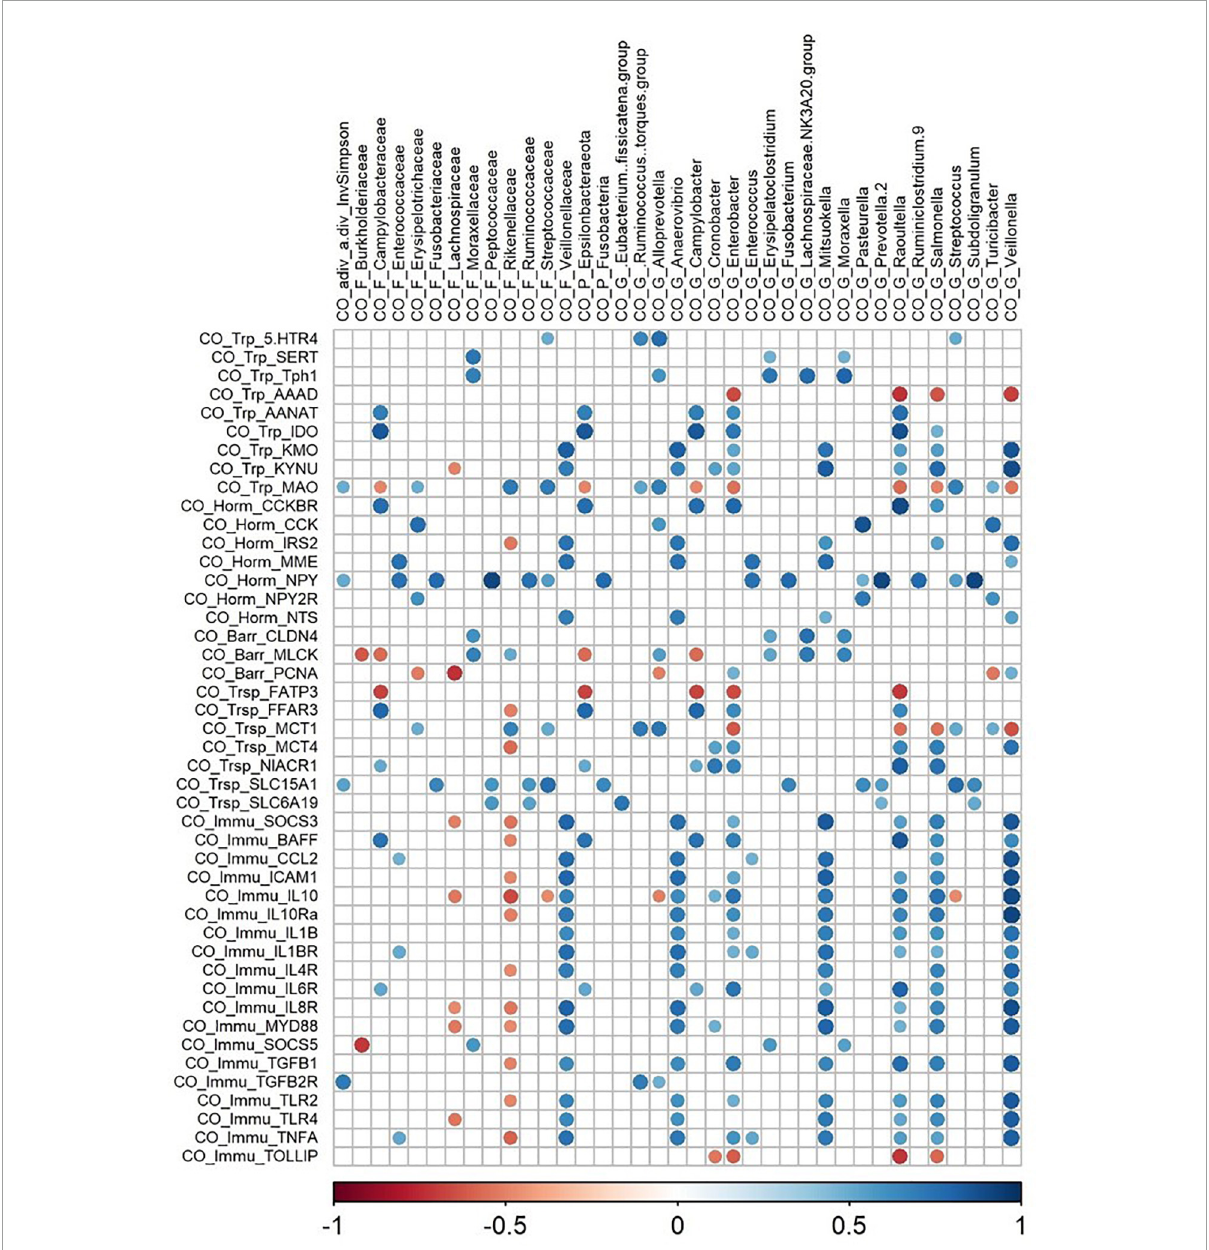
FIGURE4 Correlations matrix between colonic relative gene expression and colonic microbiota (| r | ≥ 0.7, P < 0.05). CO, colon; F, family; P, phylum; G, genera; Trp, tryptophan pathways; Horm, endocrine function; Barr, barrier function; Trsp, transport-nutrient carrier; Immu, immune